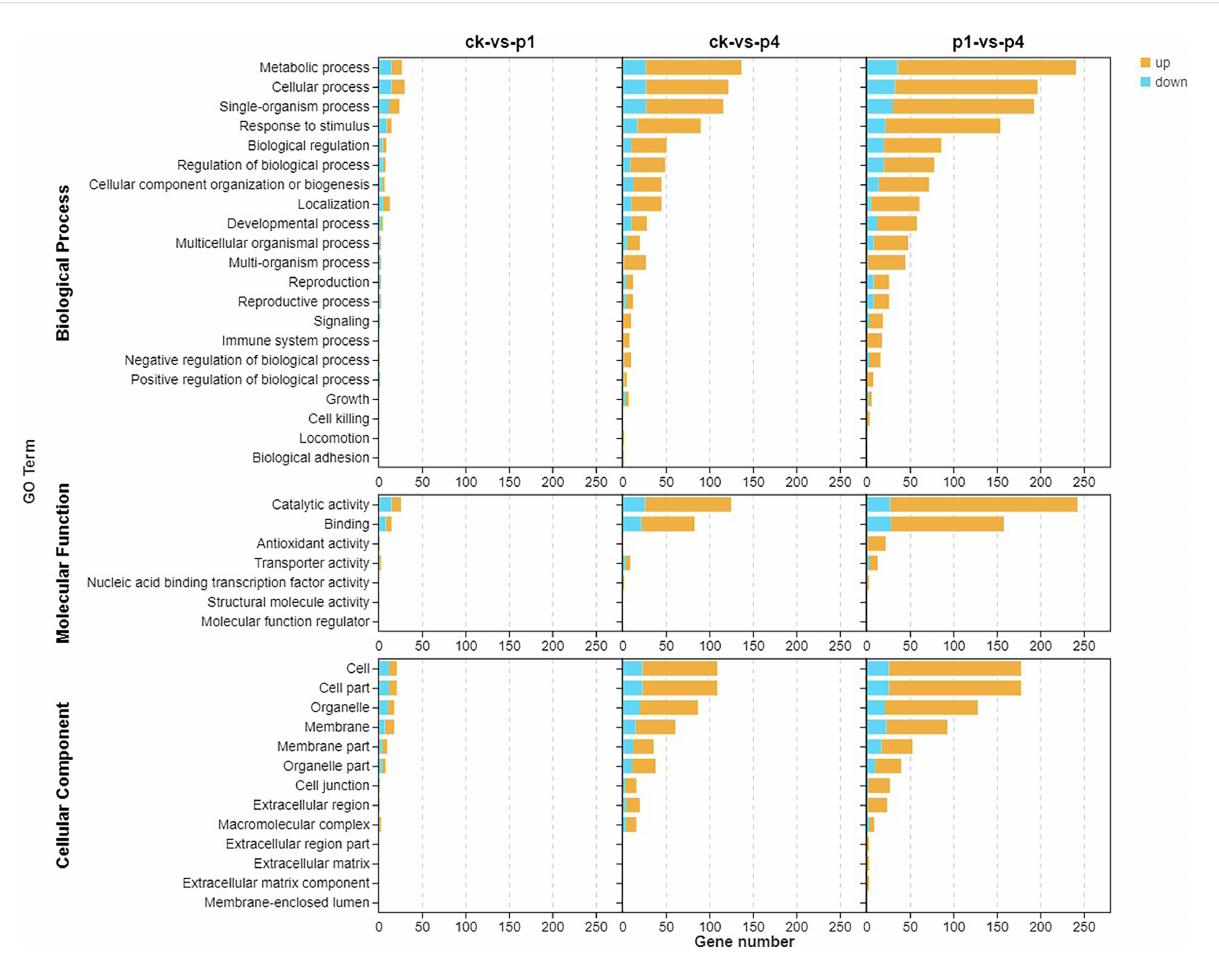
FIGURE 3 Gene Ontology (GO) enrichment analysis of the DEGs after cooling under different P treatments. DEGs, differentially expressed genes; GO, Gene Ontology; P,